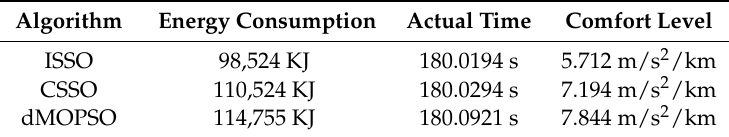
Figure 11. The HILS optimization curves of different algorithms for rail transit line No.12 in Dalian scenario. ( a ) Target velocity trajectory profiles. ( b ) Operating condition distance curves. ( c ) Iterative convergence curves of each optimization objectives. ( d ) Iterative convergence curves of unified goals. Table 10. The HILS optimization results of different algorithms for rail transit line No.12 in Dalian scenario.